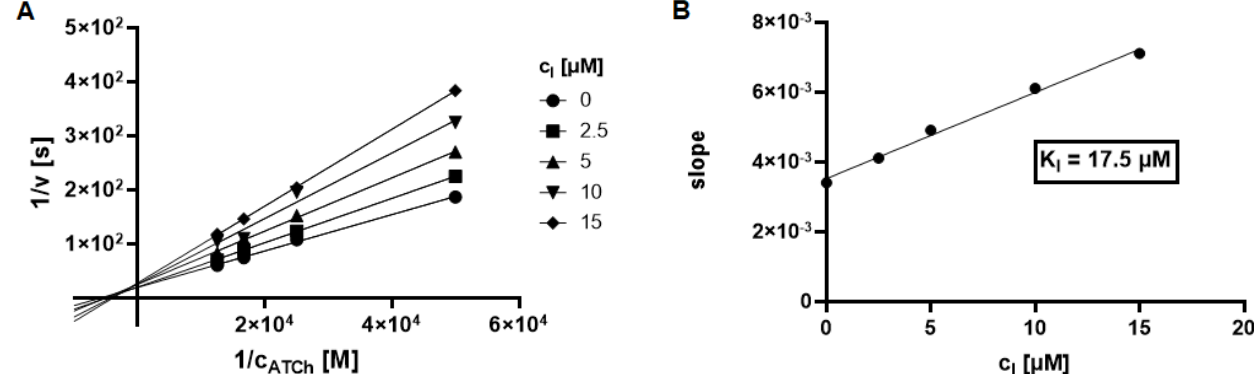
Figure 5. Lineweaver – Burk plot for compound 7 inhibiting BChE. The measurements were performed in duplicate and points are expressed as average values ( A ). Dependence of slope (Lineweaver – Burk plot) vs. concentration of inhibitor (combination BChE- 7 ) ( B ).